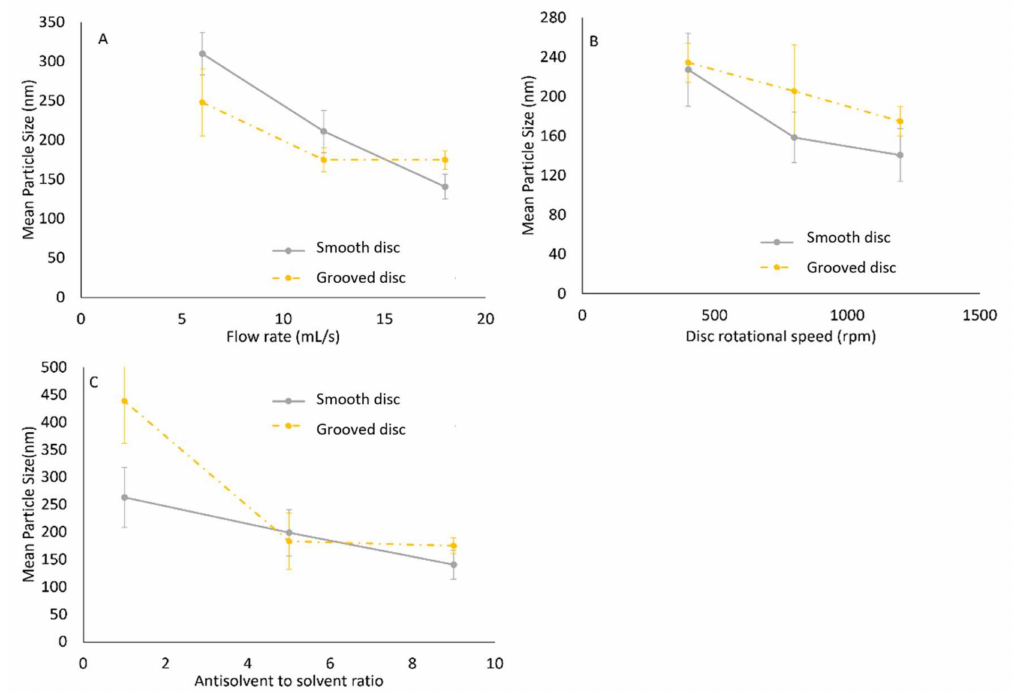
Figure 4. E ff ect of: ( A ) Flow rate (1200 rpm, 9:1 ratio); ( B ) disc rotational speed (18 mL / s, 9:1 ratio); ( C ) antisolvent to solvent ratio (1200 rpm and 18 mL / s) on particle size for smooth and grooved discs. Reproduced from [28], De Gruyter,